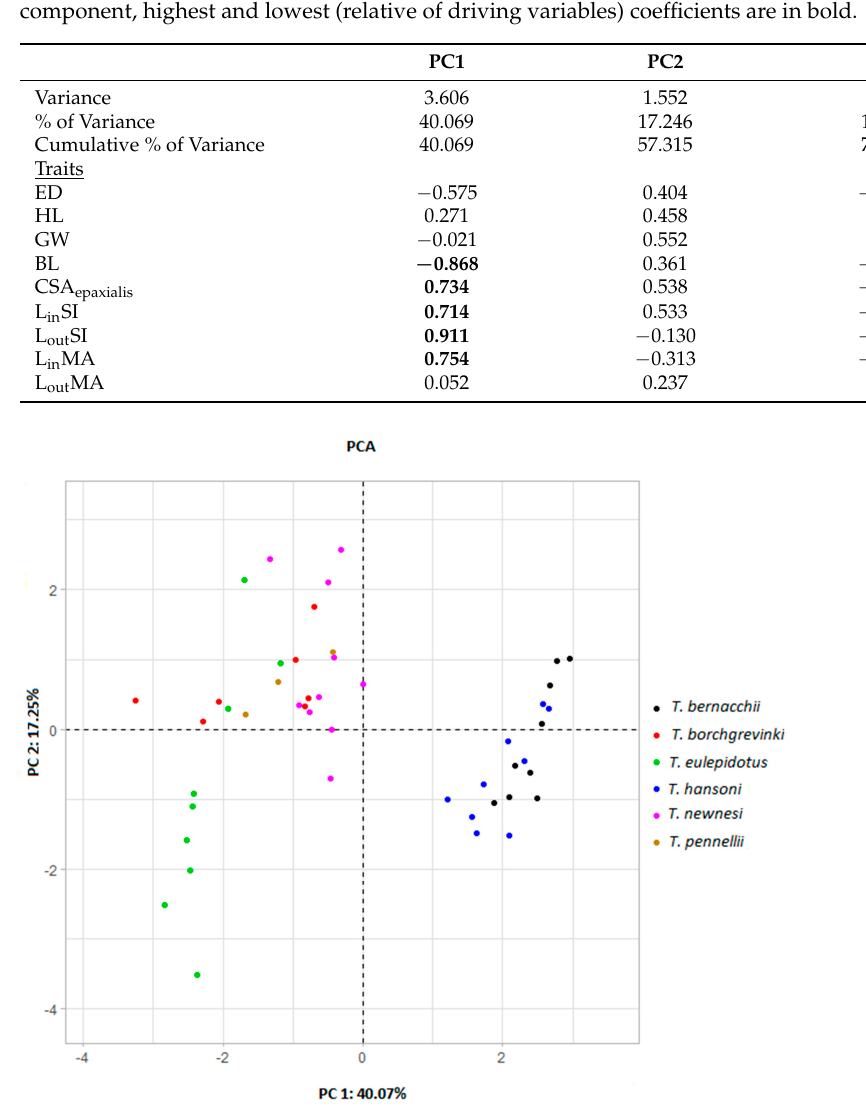
Figure 4. Principal component analysis plot developed on the 9 morphological traits of feeding apparatus of the six Trematomus species. The PCA plot developed by geometric morphometric analysis showed how the six species were distributed along the axes on the basis of their head shapes (Figure 5). The first two axes of the PCA (Figure 5) explained 62.13% of the total variability. PC1 clearly separated the benthic species T. bernacchii , T. hansoni and T. pennellii (negative PC1 values) from the pelagic T. eulepidotus and T. borchgrevinki (positive PC1 values); TPS transformations of landmark positions showed the main deformation in the position of the eyes (Figure 5). The eyes of the benthic species are oriened upwards, while in pelagic species they are in a lateral position. T. newnesi is placed in an intermediate position according to PC1.